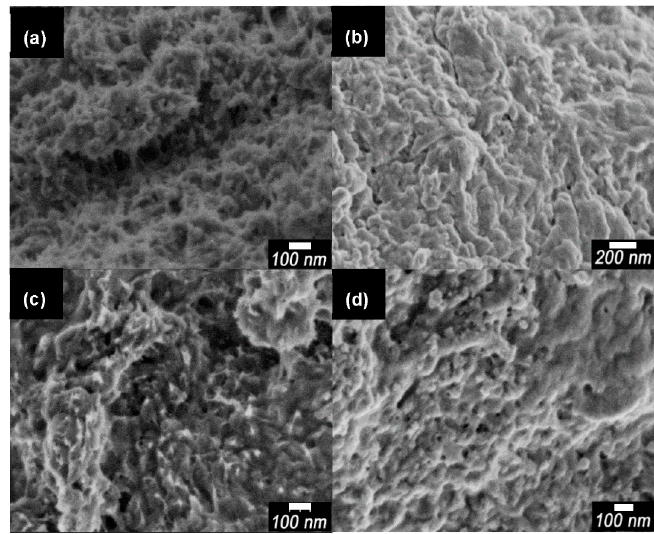
Figure 4. SEM images of PA-NF7 ( a ); PA-NF8 ( b ); PA-NF9 ( c , d ). PA-NF7 and PA-NF8 were prepared by using 1% CNF suspension (CNF/aniline = 100, feed %). PA-NF9 was prepared by using 1% CNF (EGUS) suspension (CNF/aniline = 100, feed %).